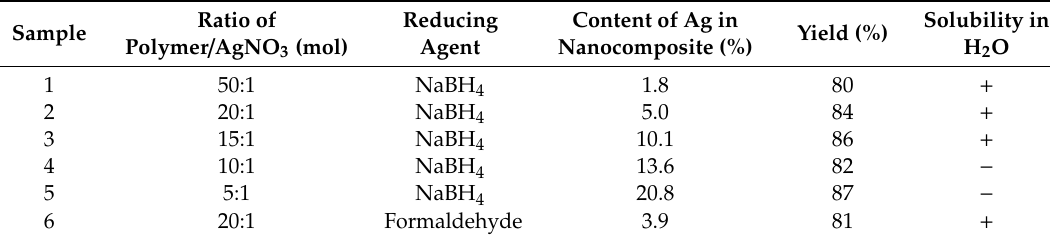
Table 1. Conditions of synthesis and properties of nanocomposites 1 – 6 with Ag nanoparticles in a matrix of